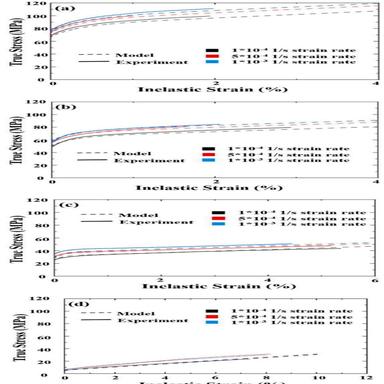
Comparison of the modified Qian-Liu model with the actual results (a) 298K, (b)323K, (c)348K, (d)373K